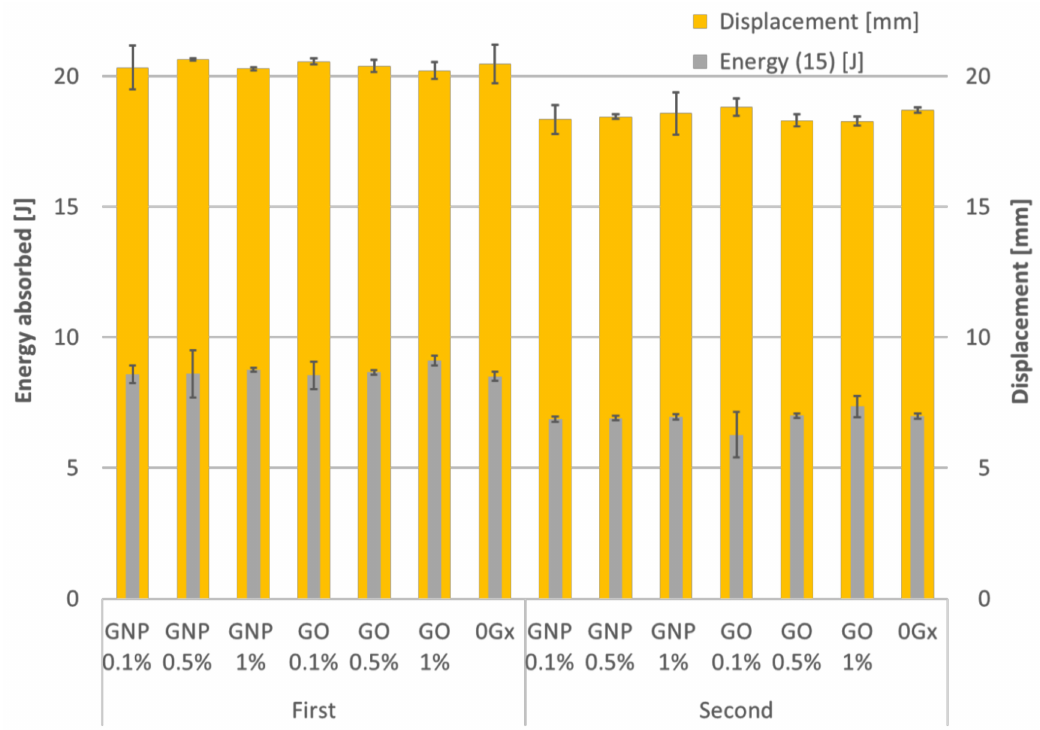
Figure 9. Absorbed energy (Energy(15)) at a sample deflection of 15 mm and displacement chart for the first and second